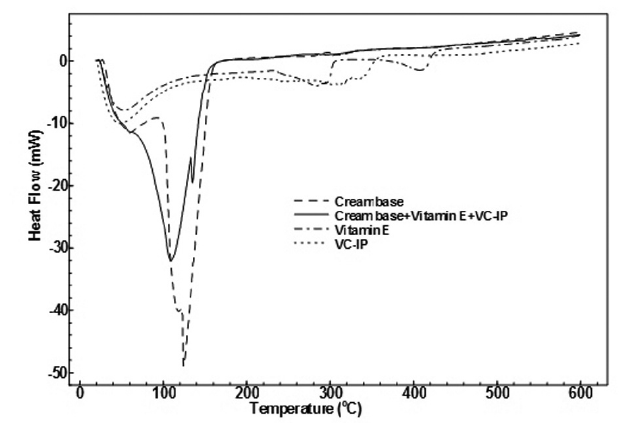
FIGURE 5 - DSC Curves of cream base, VC-IP, vitamin E and cream base with VC-IP and vitamin E samples obtained in a dynamic N2 atmosphere (50 mL min -1 ) and at a heating rate of 10 ºC min -1